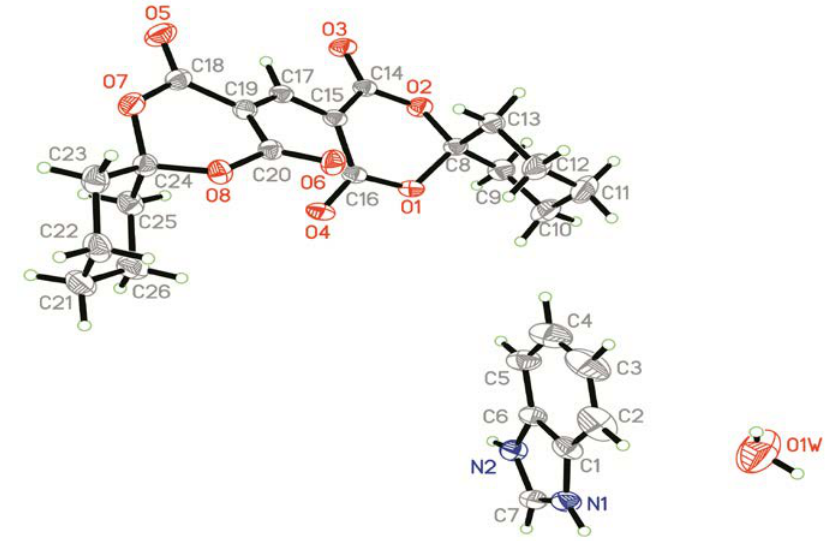
Figure 1. The molecular structure of (C 19 H 21 O 8 ) (C 7 H 7 N 2 ) (0.5H 2 O), showing 30% probability displacement ellipsoids and the atomic numbering